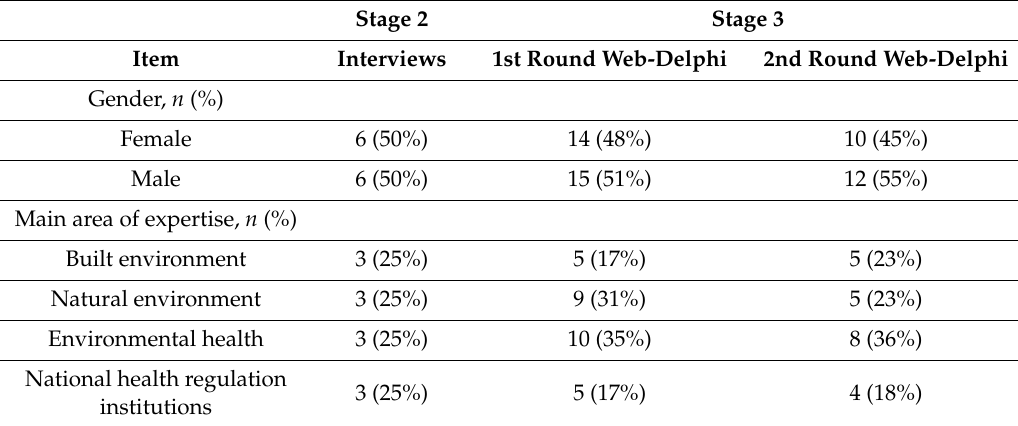
Table 1. Profile of the participants in stages 2 and 3 of the approach used to select the key dimensions and indicators to evaluate EH in the Lisbon urban